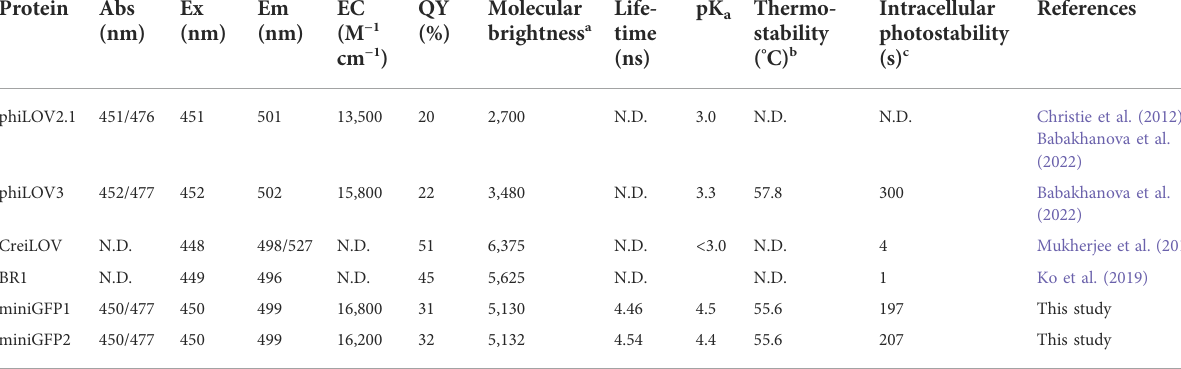
TABLE 1 Properties of the FMN-binding fl uorescent proteins, miniGFP1 and miniGFP2.